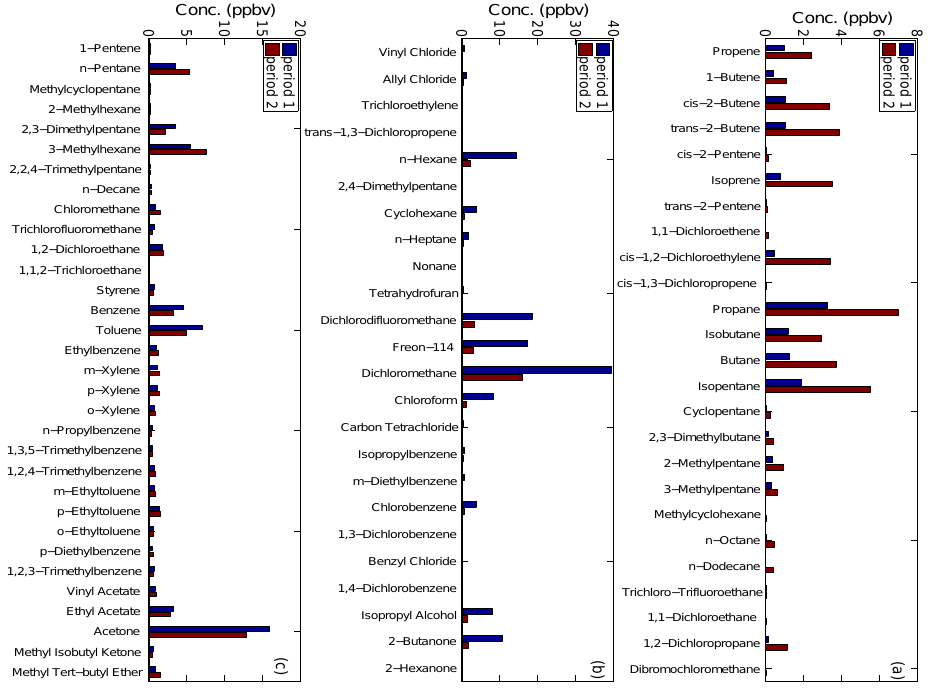
Fig. 5. Concentrations averaged over period 1 (denoted by C1) and period 2 (denoted by C2) for individual VOC species, except for 21 species that were not detected in both periods: (a) the first category: C2 > 2*C1; (b) the second category: C1 > 2*C2; (c) the third category: all those species not in category 1 and 2, whose average concentrations of both periods are comparable.